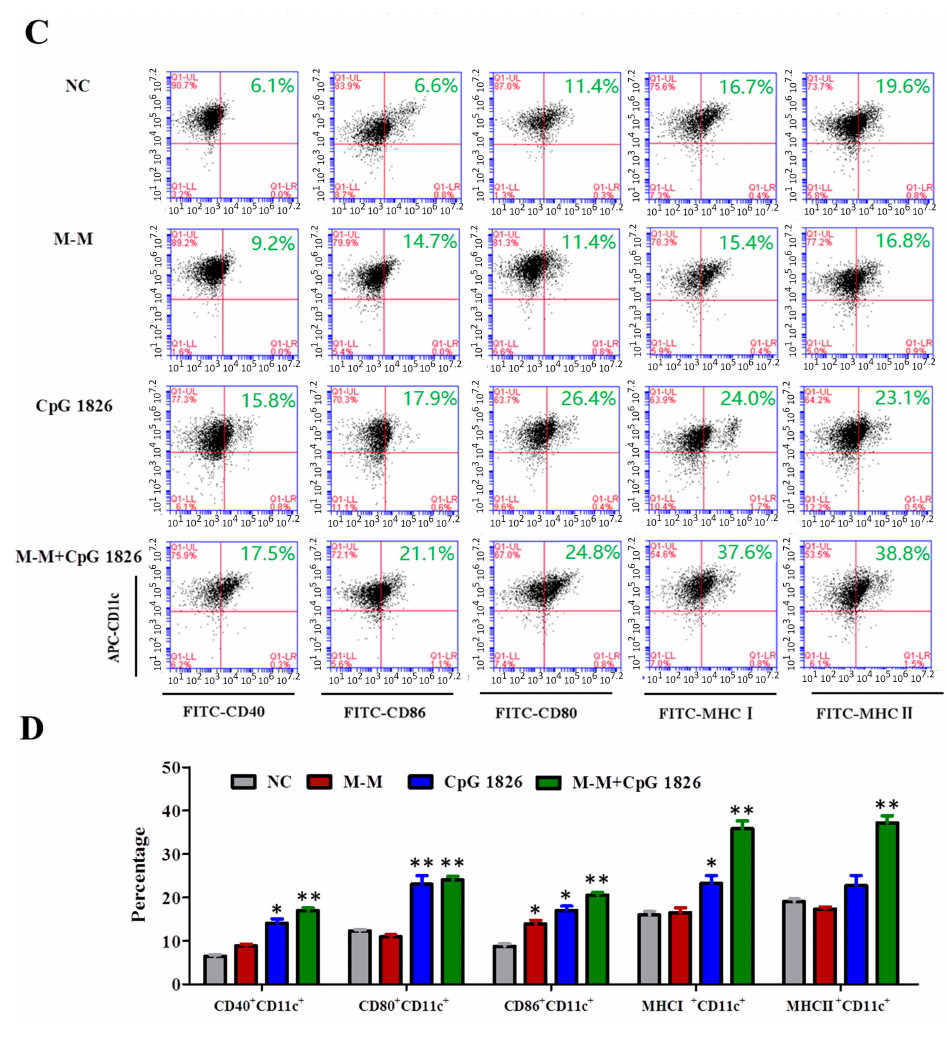
Figure 3. Effects of M-M, CpG 1826 on dendritic cell (DC) maturation in vivo and in vitro. ( A , B ) In vivo study. The draining lymph node was isolated on day 0 after an s.c. injection of PBS, M-M, CpG 1826 or M-M + CpG 1826 in the flank of the C57BL/6 mice on day –21 and –7. The draining lymph node was made into single cell suspensions. ( A ) The expression of major DCs surface markers was analyzed by flow cytometry. ( B ) The in vivo percentage of the (double positive) DC cells is expressed as the mean ± standard deviation and is shown in a bar graph. ( C , D ) In vitro study. ( C ) The percentage of dual-positive (DP) cells is shown in the flow cytometry histogram. The BMDCs were analyzed for the expression of CD40 + CD11C + , CD80 + CD11C + , CD86 + CD11C + , MHCI + CD11C + , MHCII + CD11C + by flow cytometry after stimulation with PBS, M-M, CpG 1826, or M-M + CpG 1826 for 48 h in vitro. ( D ) The in vitro percentage of (DP) cells is expressed as the mean ± standard deviation and is shown in a bar graph. The data are representative of three independent experiments. * p < 0.05, ** p < 0.01 vs. the NC